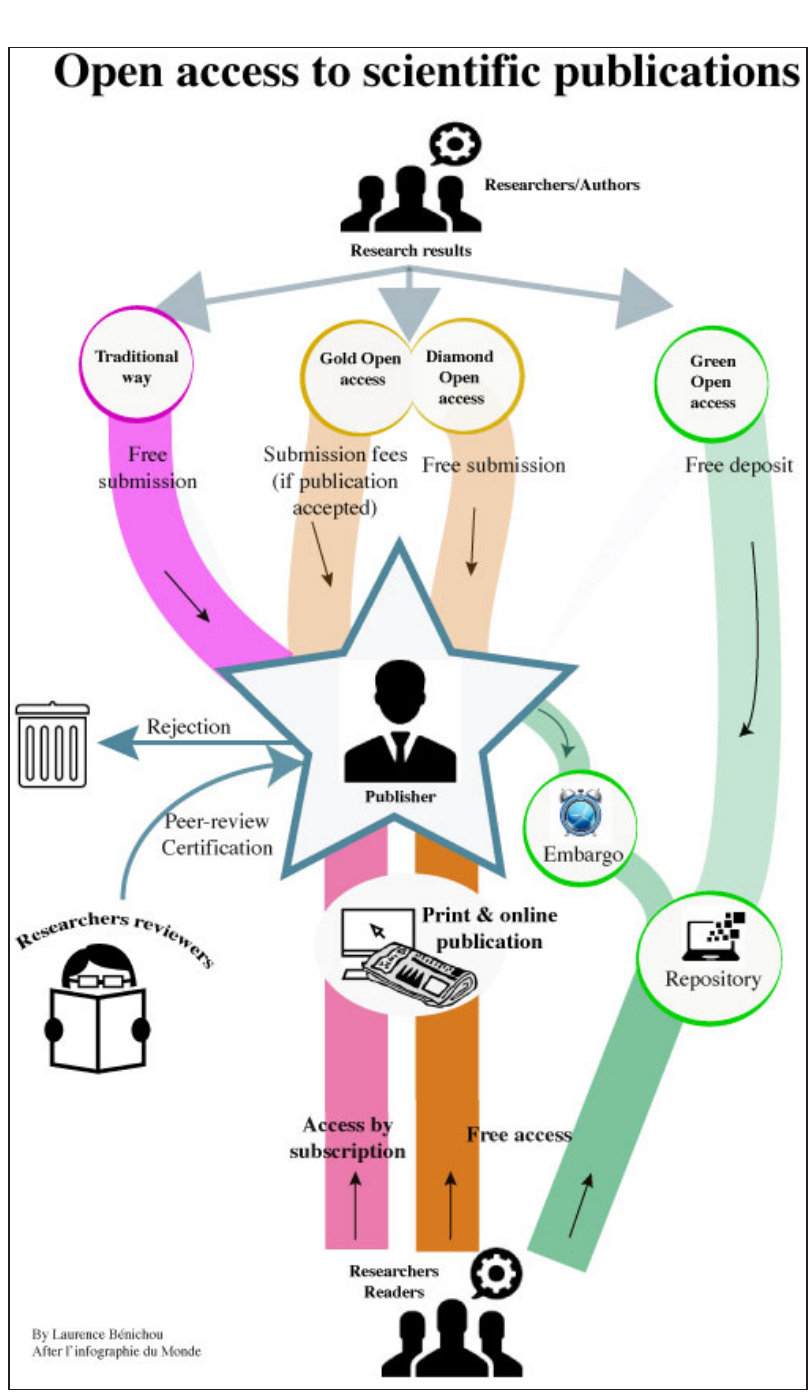
Fig. 15. Different routes for disseminating scientific publications (Cabut & Larousserie 2013, redrawn by Laurence Bénichou from Infographie du